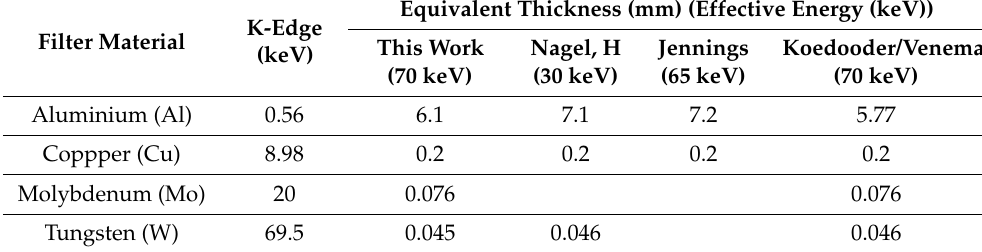
Table 1. Filter thickness being hardness equivalent to 0.2 mm copper depends on the filter material